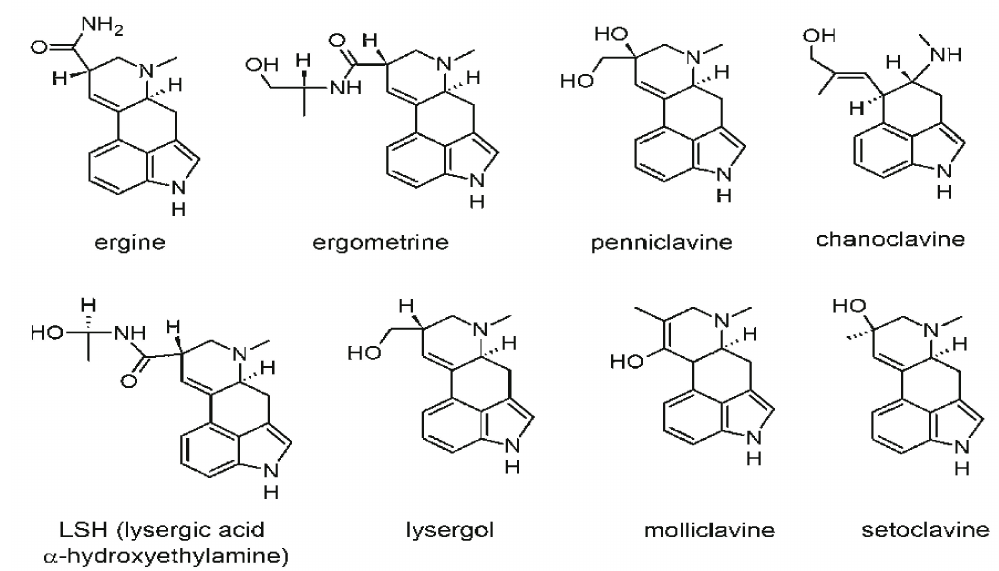
Figure 2. Chemical structures of some common ergot alkaloids (Reprinted/Adapted from sources